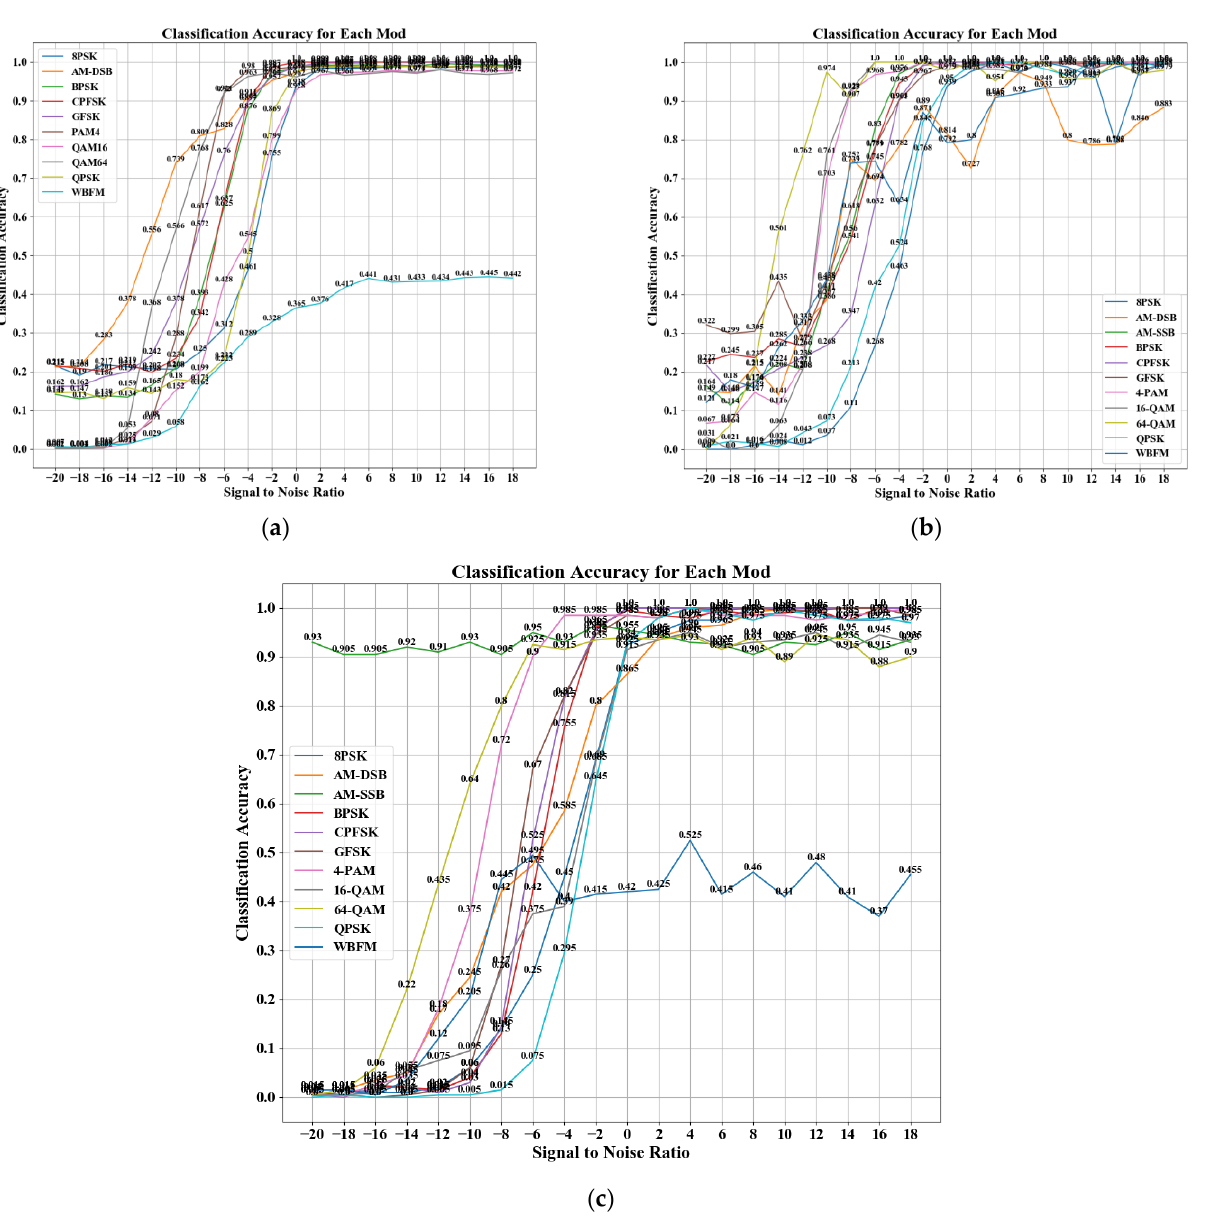
Figure 11. Accuracy for each category at each SNR on three datasets. ( a ) RML2016.10b; ( b ) RML2016.04c; ( c ) RML2016.10a.